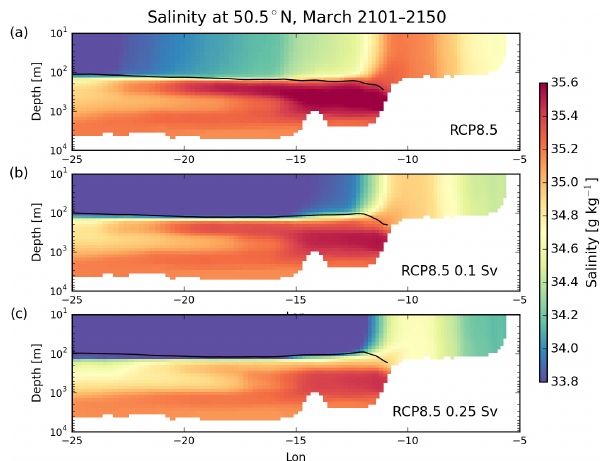
Figure A7. Vertical salinity distribution at 50.5 ◦ N during the shallow-ML regime (2101–2150) for experiments E0 (a) , E010 (b) and E025 (c) . Black contour line represents mean MLD.